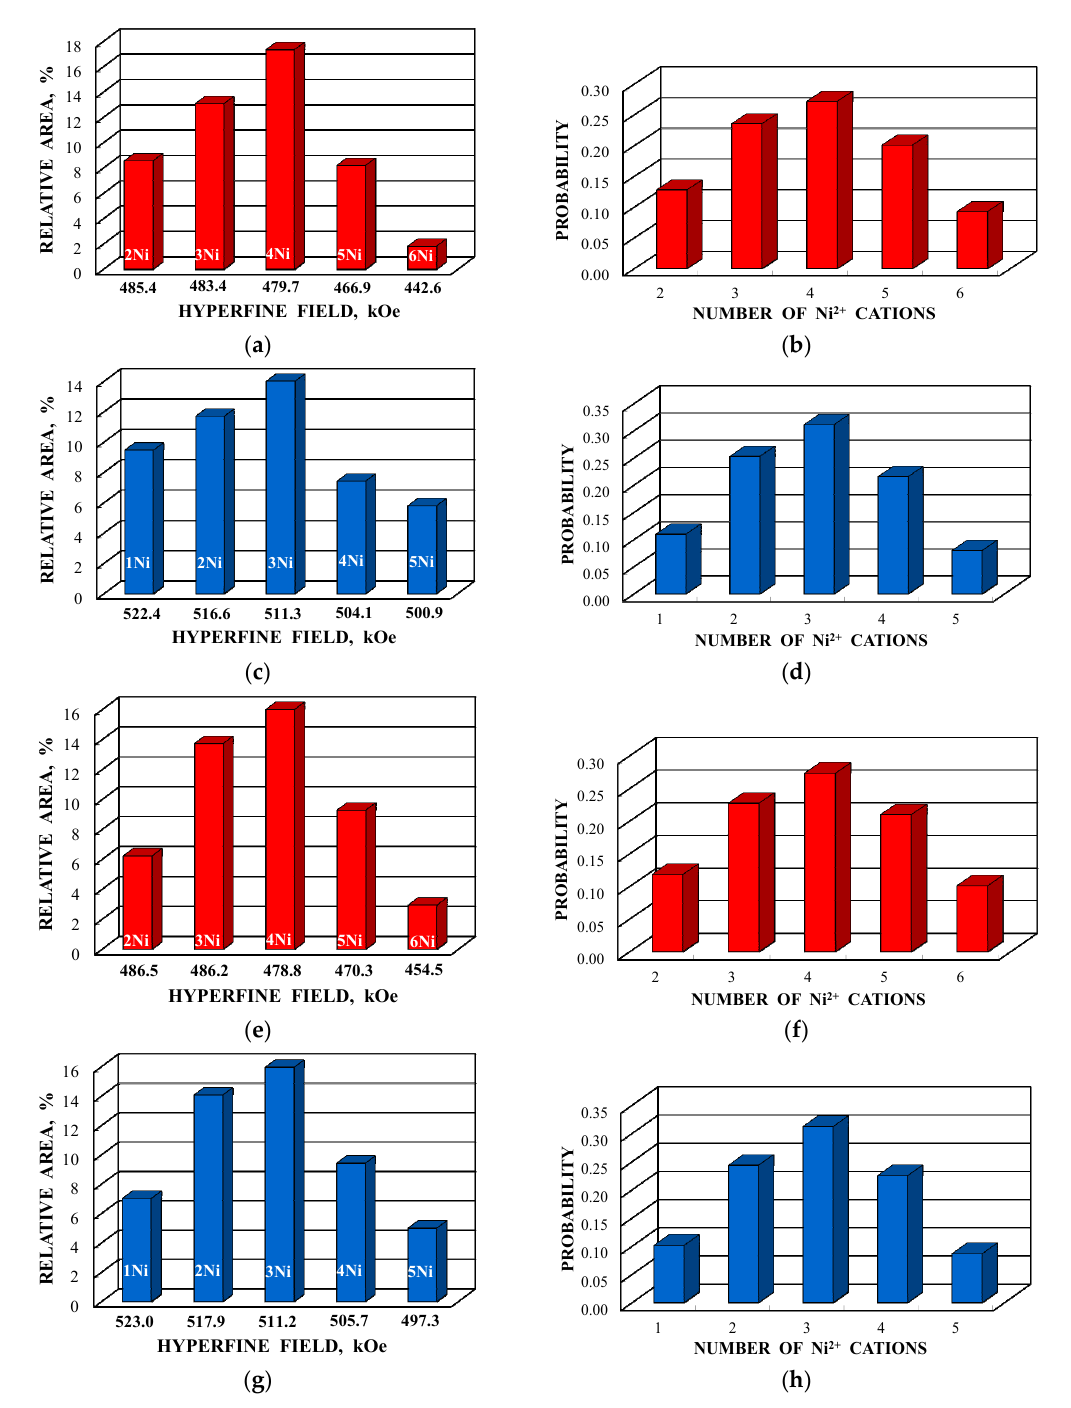
Figure 53. Comparison of histograms of the relative areas of spectral components assigned to the (A) ( a , e ) and [B] ( c , g ) sites in the Mössbauer spectra of NA ( a , c ) and NB ( e , g ) samples with H eff decrease and corresponding histograms of the reliable probabilities ( ≥ 0.5) of different numbers of Ni 2+ cations in the local microenvironments of Fe 3+ A ( b , f ) and Fe 3+ B ( d , h ) cations within the coordination sphere of 3.5 Å in the ideal NiFe 2 O 4 crystal with chemical compositions corresponding to NA ( b , d ) and NB ( f , g ) samples. Adapted from Ref. [79] with permission from Elsevier: Materials Chemistry and Physics, Vol. 202, Ushakov M.V., Senthilkumar B., Kalai Selvan R., Felner I., Oshtrakh M.I., “Möss‑ bauer spectroscopy of NiFe 2 O 4 nanoparticles: the effect of Ni 2+ in the Fe 3+ local microenvironment in both tetrahedral and octahedral sites”, 159–168,